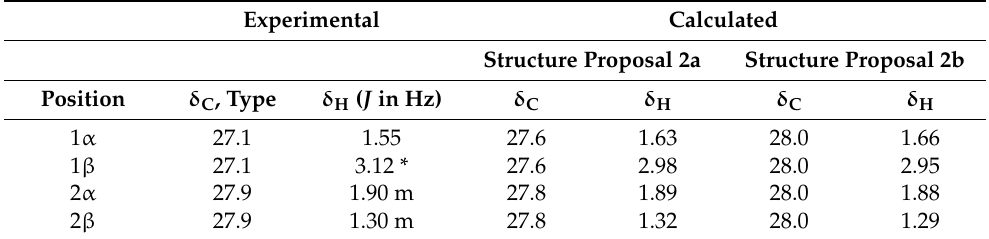
Table 2. Experimental and computed NMR data (400 MHz, (CD 3 ) 2 SO) of compound 2 (minor